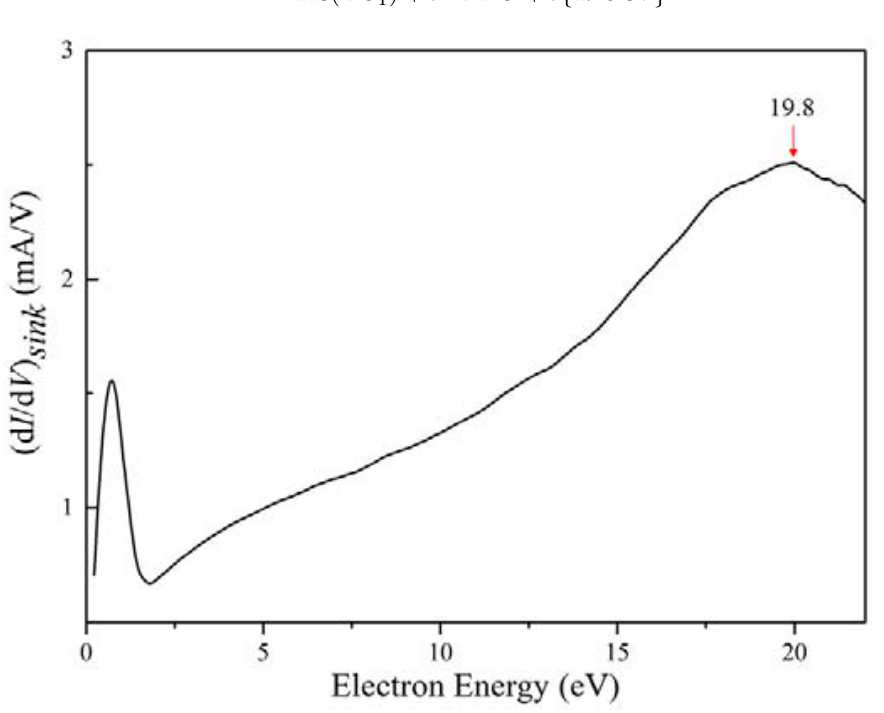
Figure 4. The first derivative modified by sink parameters for helium at atmospheric pressure with a flow rate of 5 mL/min and the discharge current of 10.7 mA, where 19.8 eV is the characteristic electron peak of He.